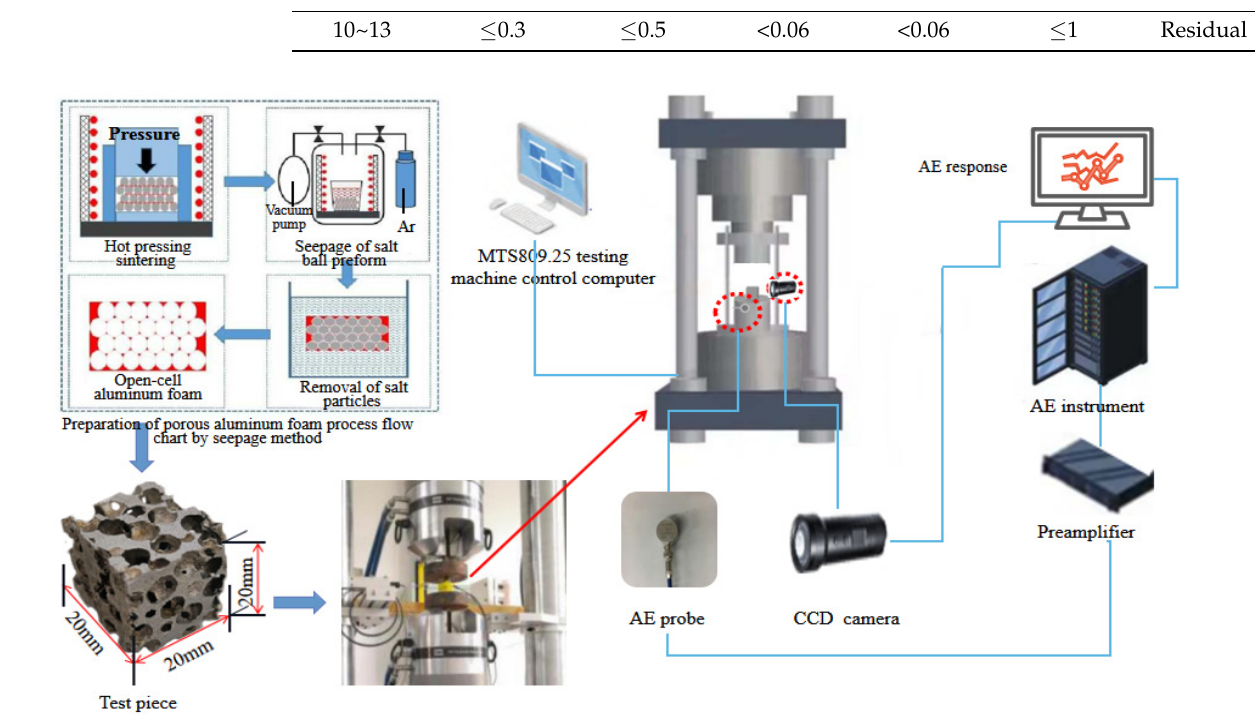
Table 2. VS150-RIC transducer probe parameters.